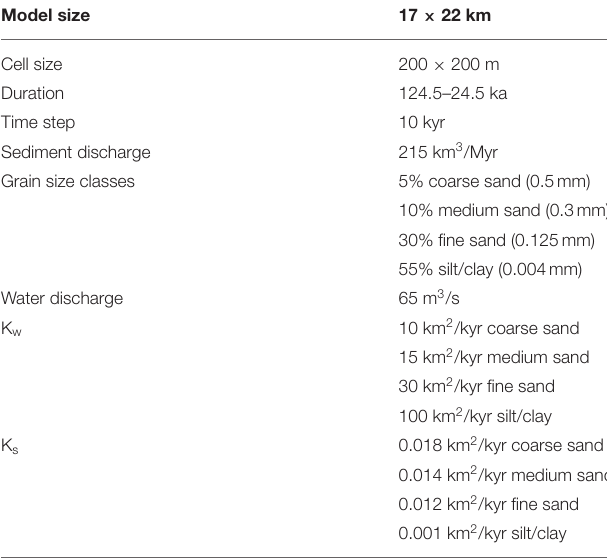
TABLE 1 | Reference-case model